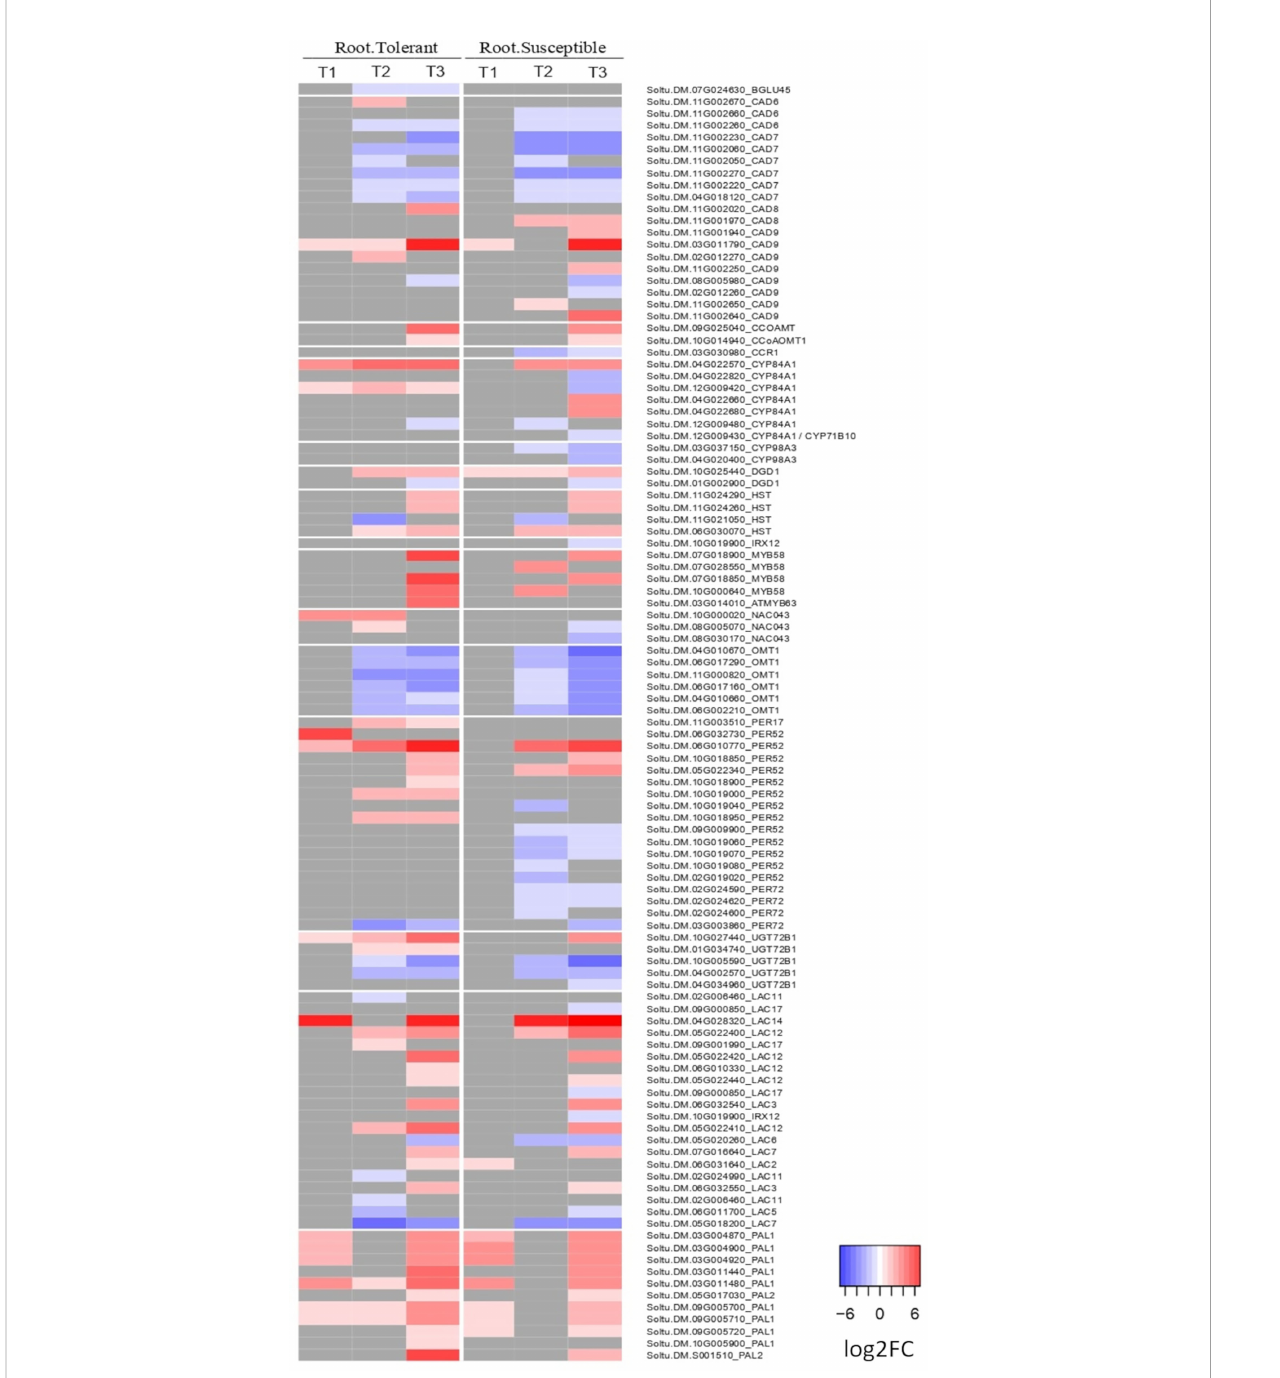
FIGURE 5 Heatmap of the log2 fold change of DEGs related to lignin biosynthesis in roots. Shown is the log2FC compared to the non-stressed control for all DEGs annotated with lignin biosynthetic process (GO:0009809), lignin catabolic process (GO:0046274) or as laccase genes in the potato genome v6.1. In grey are genes with no signi fi cant change in the respective time point (early T1, late T2, and recovery T3), tissue, or